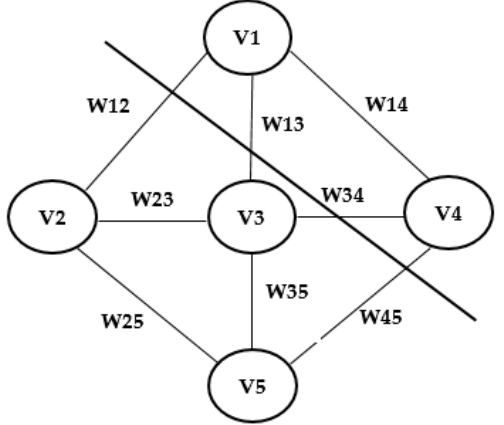
Figure 2. The graphical representation of the foreground and background objects using the Grab- Cut